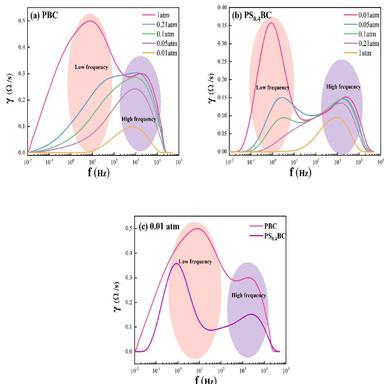
Resultant DRT of (a) PBC and (b) PS0.4BC symmetric cell measured at 800 ◦C in different partial oxygen pressures; (c) PBC and PS0.4BC measured at 800 ◦C in 1atm partial oxygen pressures.